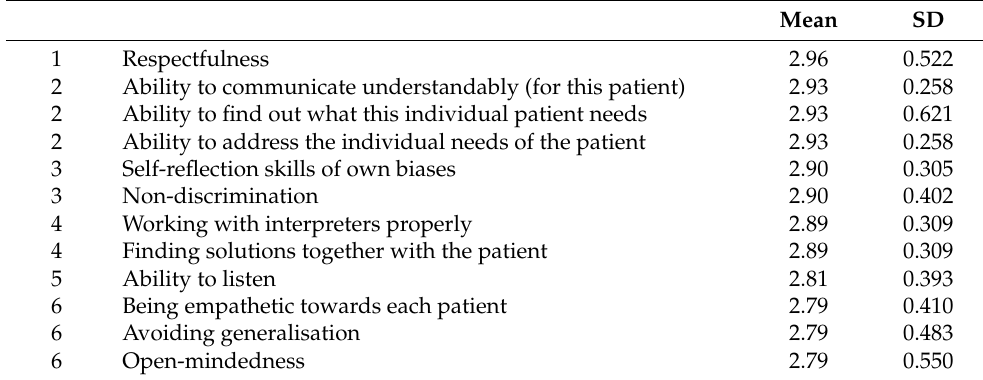
Table 3. Highest ranked competences (according to mean value) across